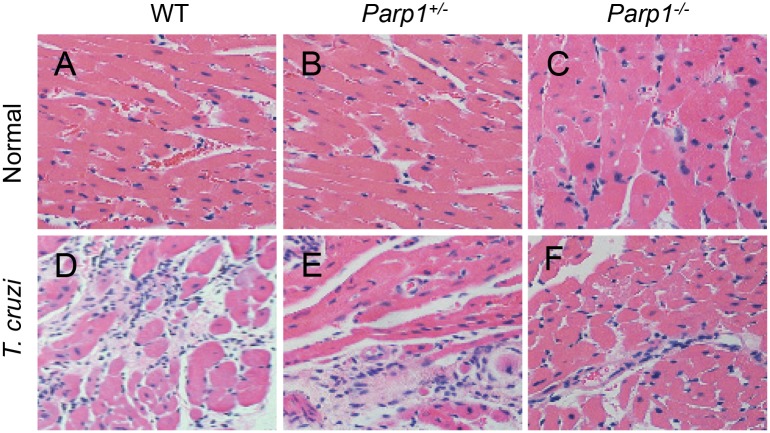
Histological evaluation of myocardial inflammation in chronically infected mice (± PARP1).Mice (WT, Parp1+/-, and Parp1-/-) were challenged with T. cruzi (10,000 parasites per mouse) and euthanized at 150 days post-infection. Paraffin-embedded left ventricular heart tissue sections (5 μM) were examined by hematoxylin/eosin staining (blue: nuclear; pink: muscle/cytoplasm). Shown are representative H&E stained images of tissue sections from (A-C) non-infected and (D-F) chronically infected WT (A&B), Parp1+/-
(B&E), and Parp1-/-
(C&F) mice. Average histological score ± SD values were derived from analysis of n = 3 mice per group, 2–3 tissue sections per mouse, 10 microscopic fields per tissue section, and discussed in Results section.